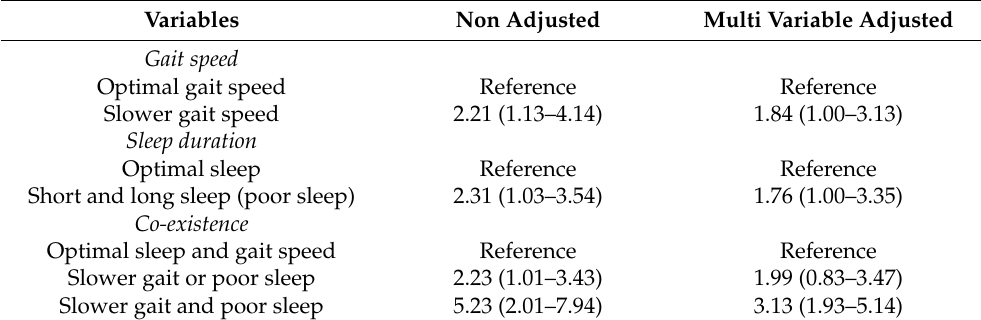
Table 2. Adjusted odds ratios (95% confidence intervals) for the risk of developing MCI in categories of gait speed and sleep duration in older adults.